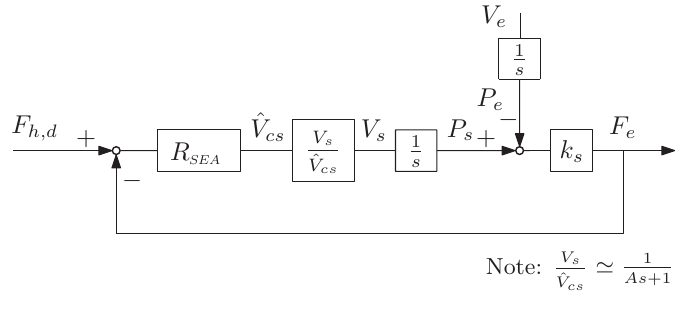
Figure 9. Control block diagram of the